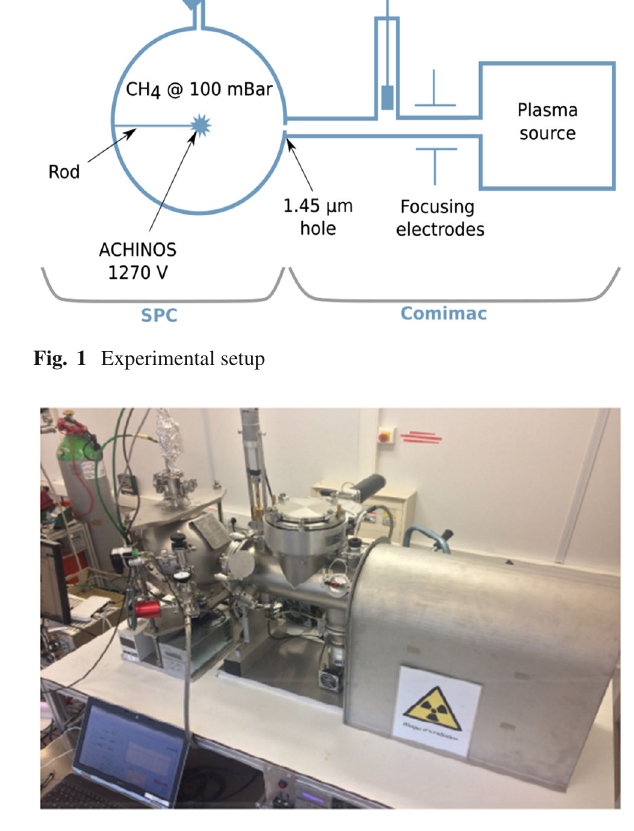
Fig. 2 A picture of the experiment with Comimac on the right and the SPC on the